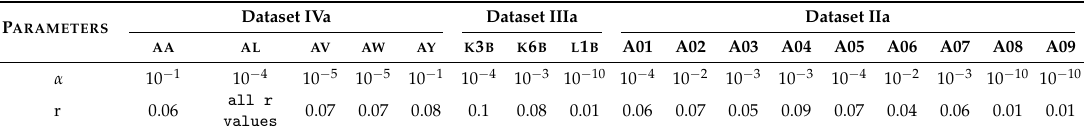
Table 2. Regularization Parameters α , r of SR-MDRM for all subjects belonging to different datasets. P ARAMETERS